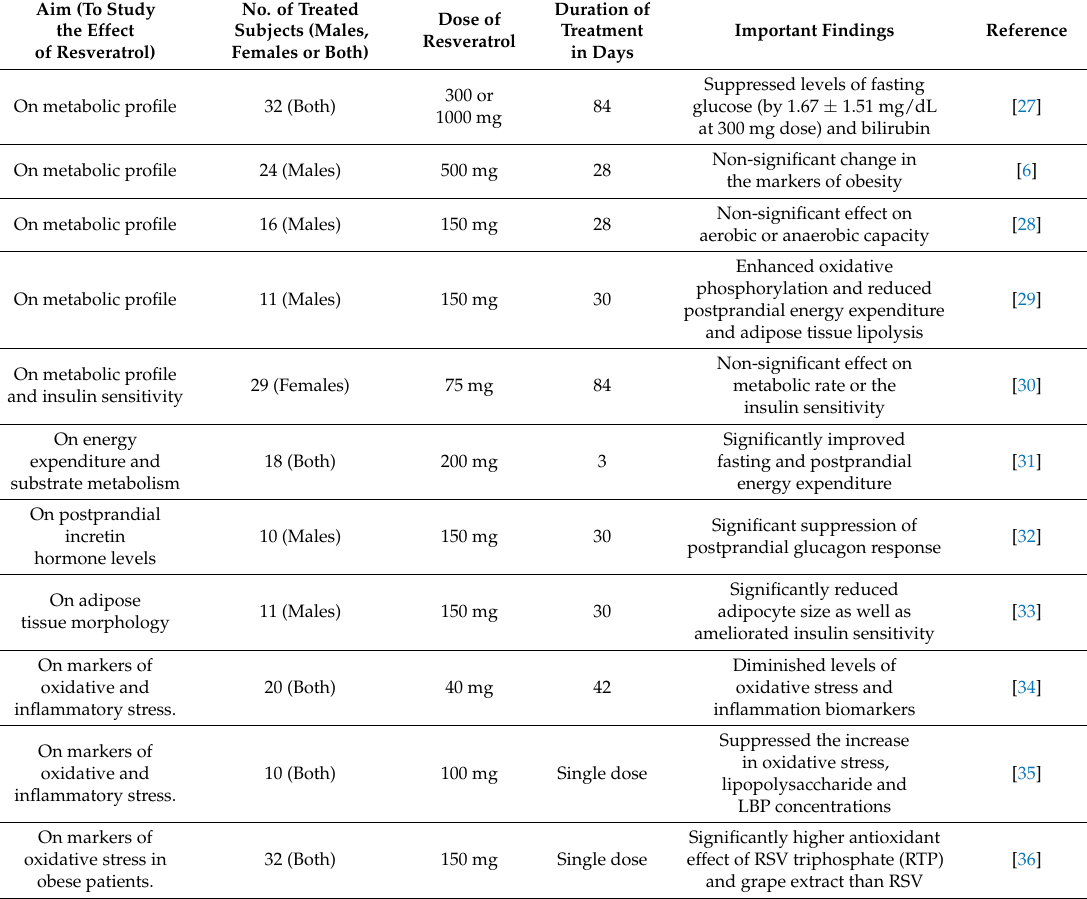
Table 2. Clinical investigations on healthy subjects (participants receiving no other medicine) supplemented with